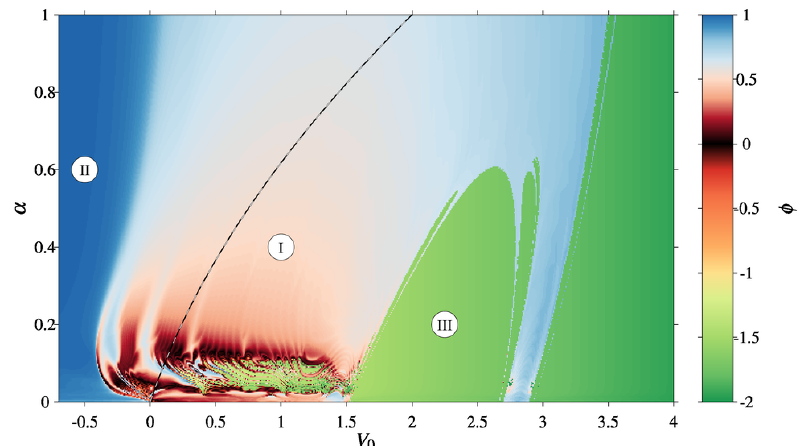
Figure 9 . Minimal value of (cid:30) (0 ; t ) for 80 < t < 100 for A 0 = 0 : 4. The dashed curve corresponds to the parameters of the exact solution for the internal mode in the potential V ( x ). White-red regions (I) correspond to oscillational mode (if V 0 > 0) and well developed stable oscillon (if V 0 (cid:20) 0), dark blue (II) correspond to unstable oscillon, yellow-green (III) kink antikink creation.